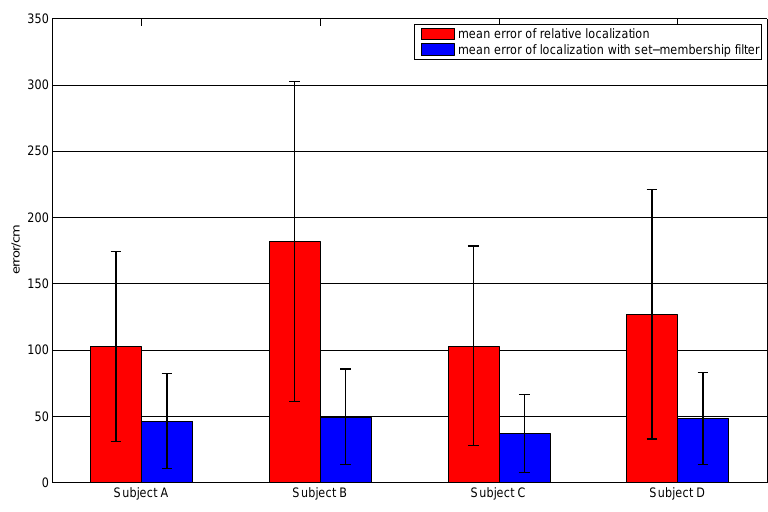
Figure 19. The mean (error bar) and standard deviation (black lines on the error bar) of the localization error per subject using the relative localization algorithm and the proposed algorithm.